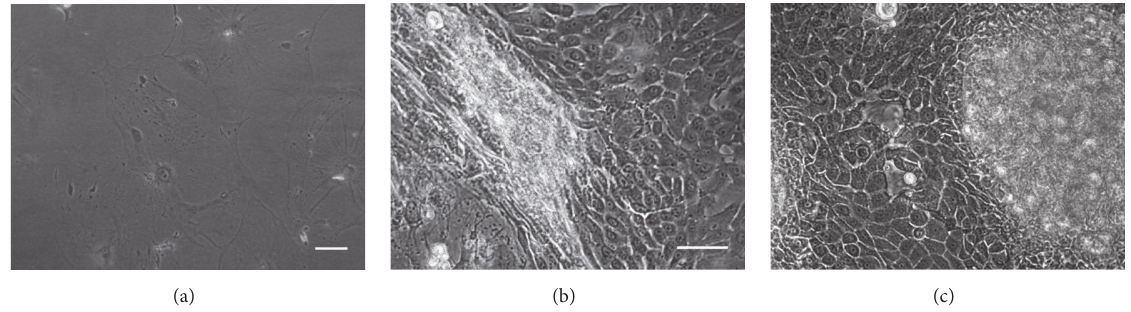
Figure 6: Micrographs of the clones from CFE. (a) No colonies grew in CFE of LSC form donors aged < 60 years. (b) The morphology of the LSC clones from donors aged 60–75 years. (c) The morphology of the LSC clones from donors aged > 75 years. Scale bar = 20 𝜇